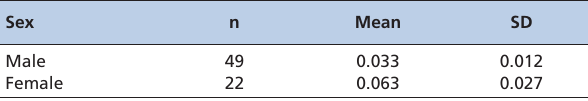
Table 3 - The number of individuals, means, and standard deviations of female and male subjects aged 21 – 40 years